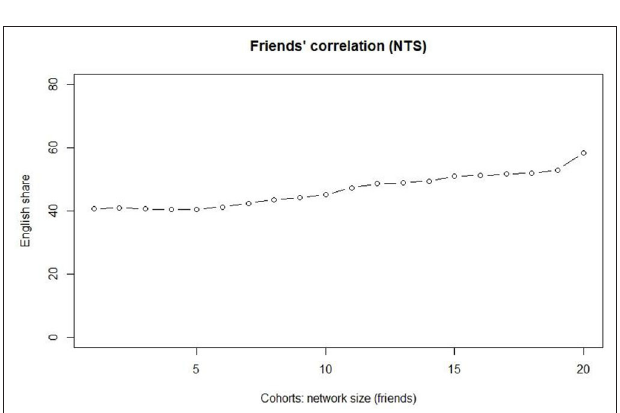
FIGURE 4 | The correlation between 20-cohort friend category and the